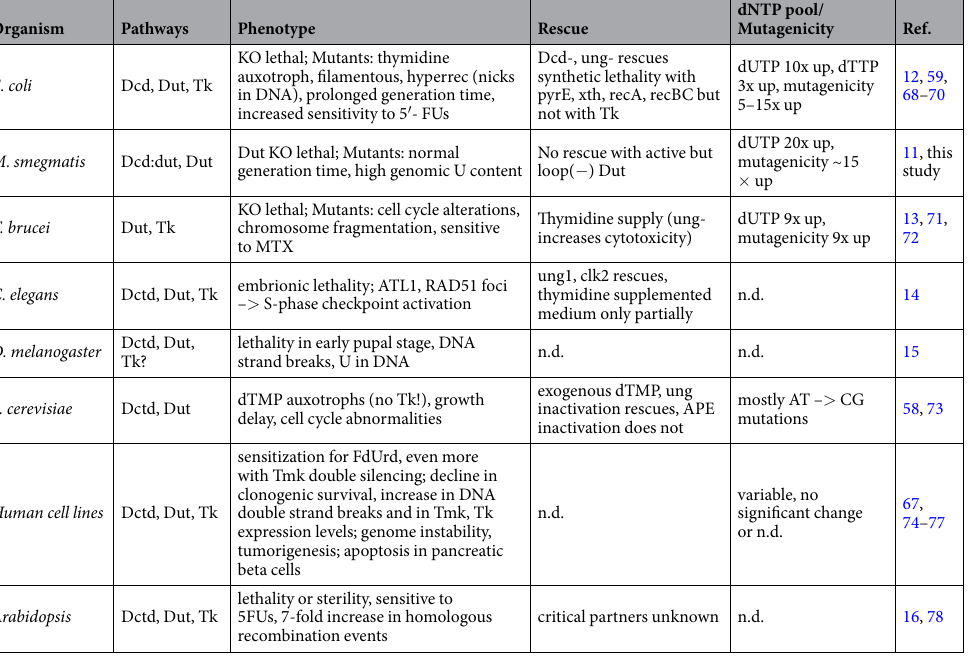
Table 2. The effects of dUTPase modification in various Methods